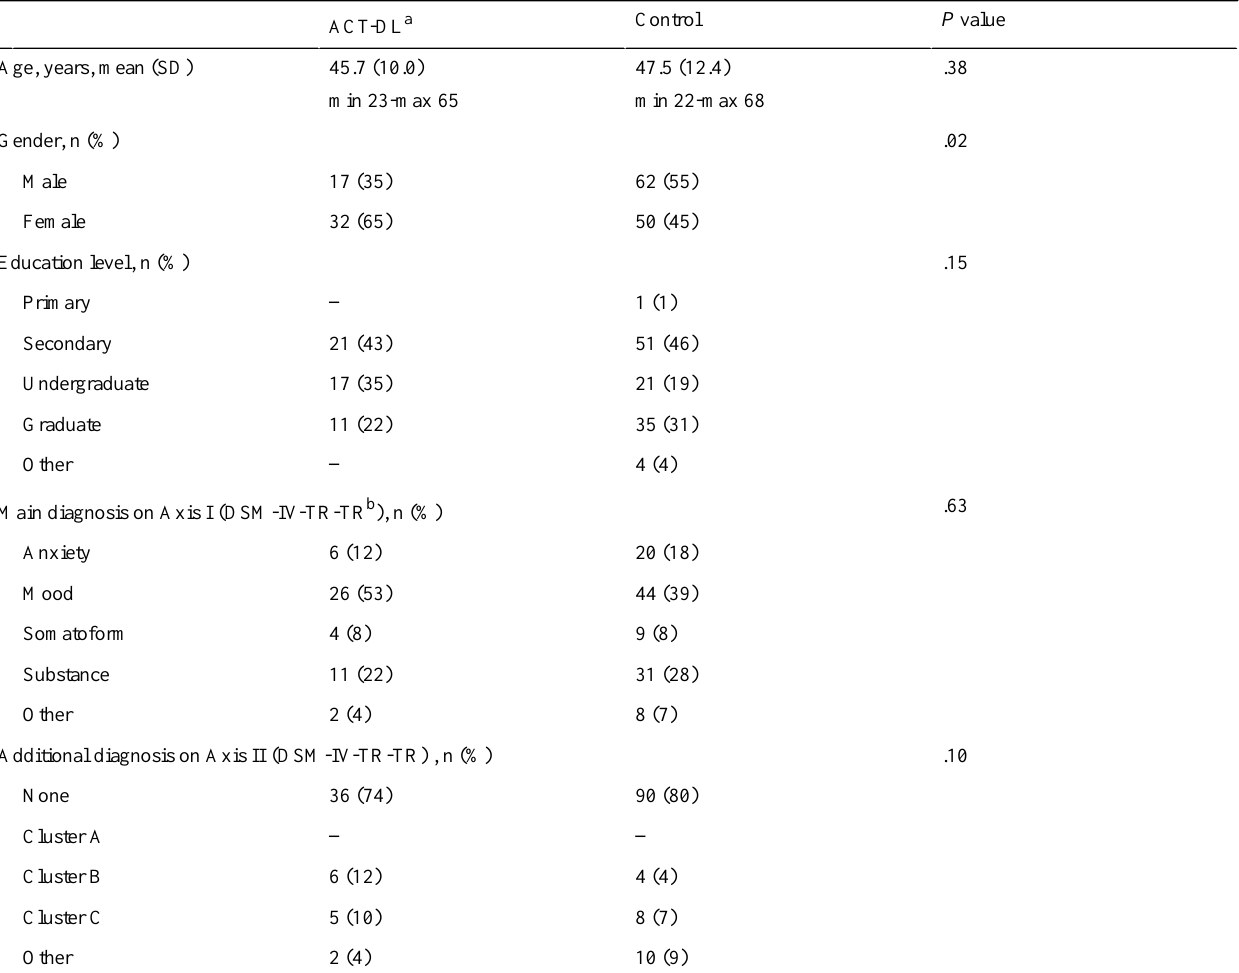
Table 1. Demographic characteristics of participants in the intervention (n=49) and control (n=112)